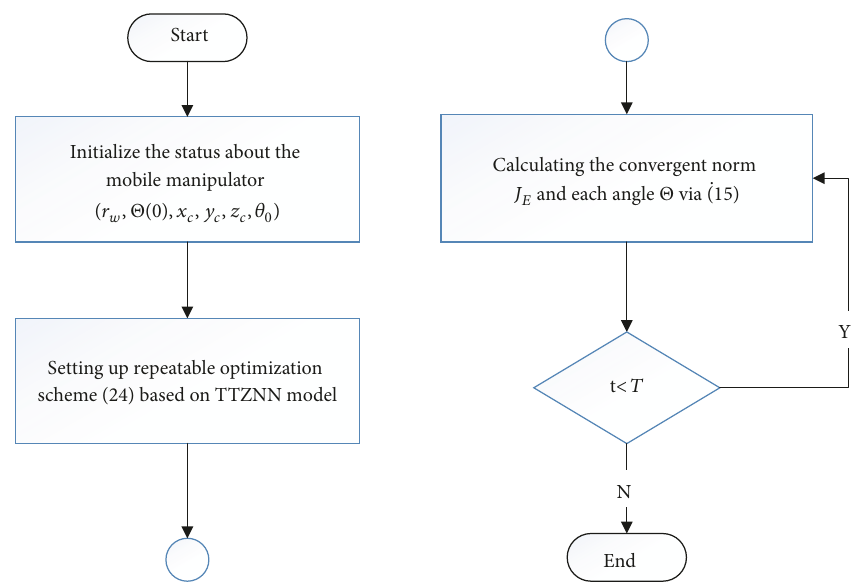
Figure 4: The flowchart of TTZNN model for kinematic planning of the mobile manipulator.